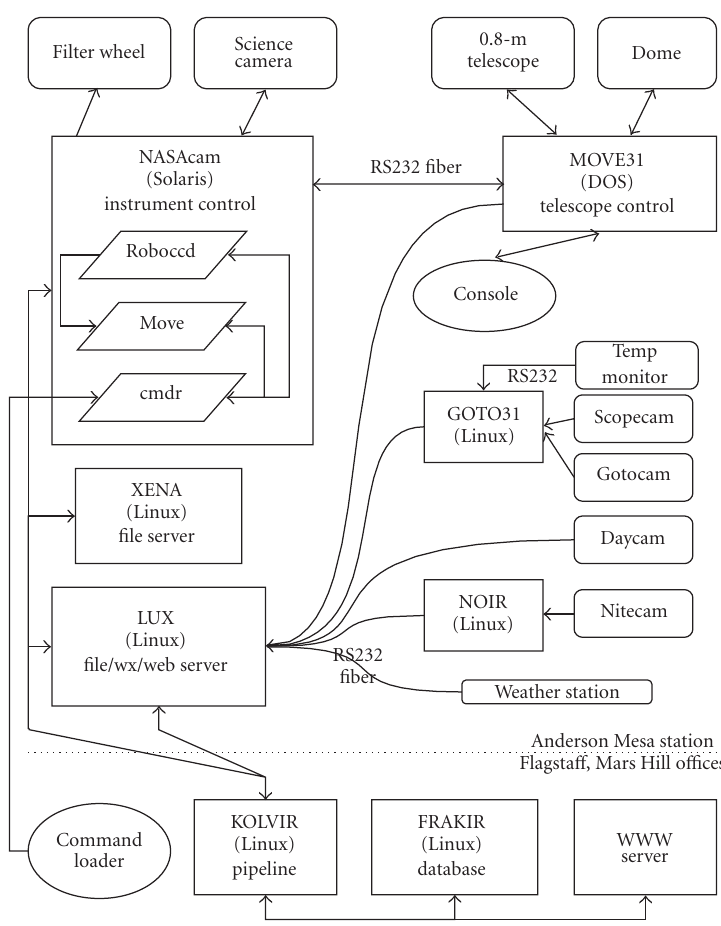
Figure 1: System overview; see text for details.